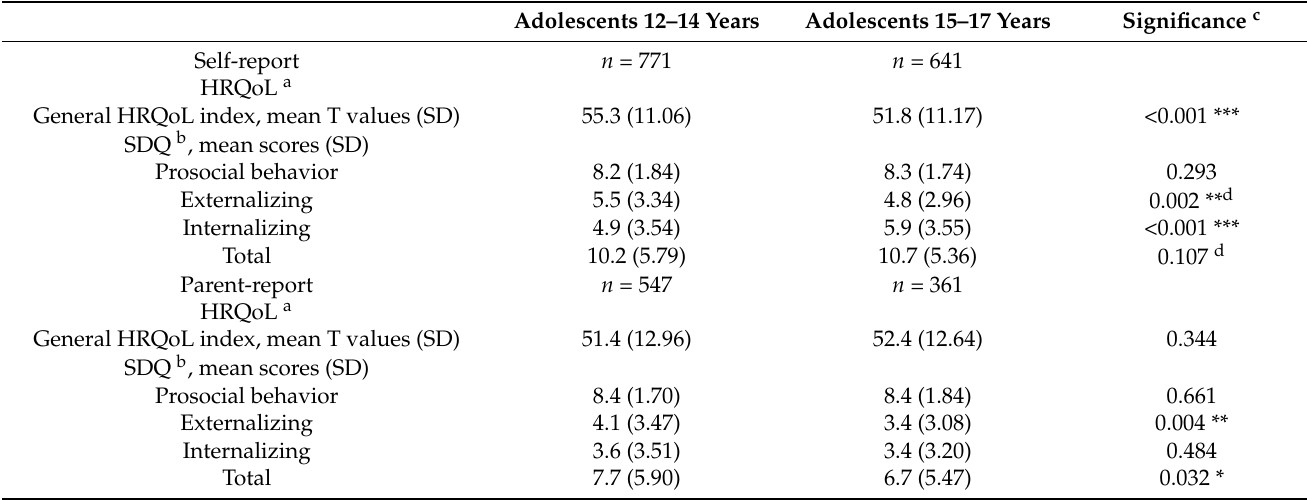
Table 2. Self- and parent-reported HRQoL and psychological symptoms in different age